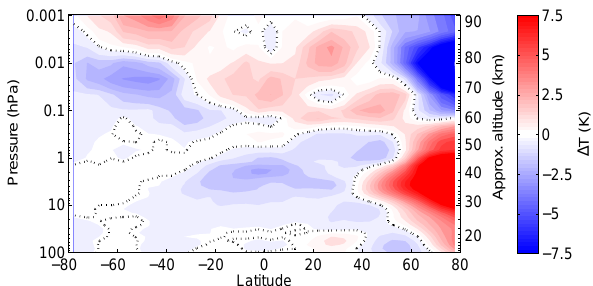
Figure 4. 10-day average zonal mean temperature anomaly shown for the middle atmosphere, centred 9 days after the SSW onset. The zero contour has been highlighted with a dotted